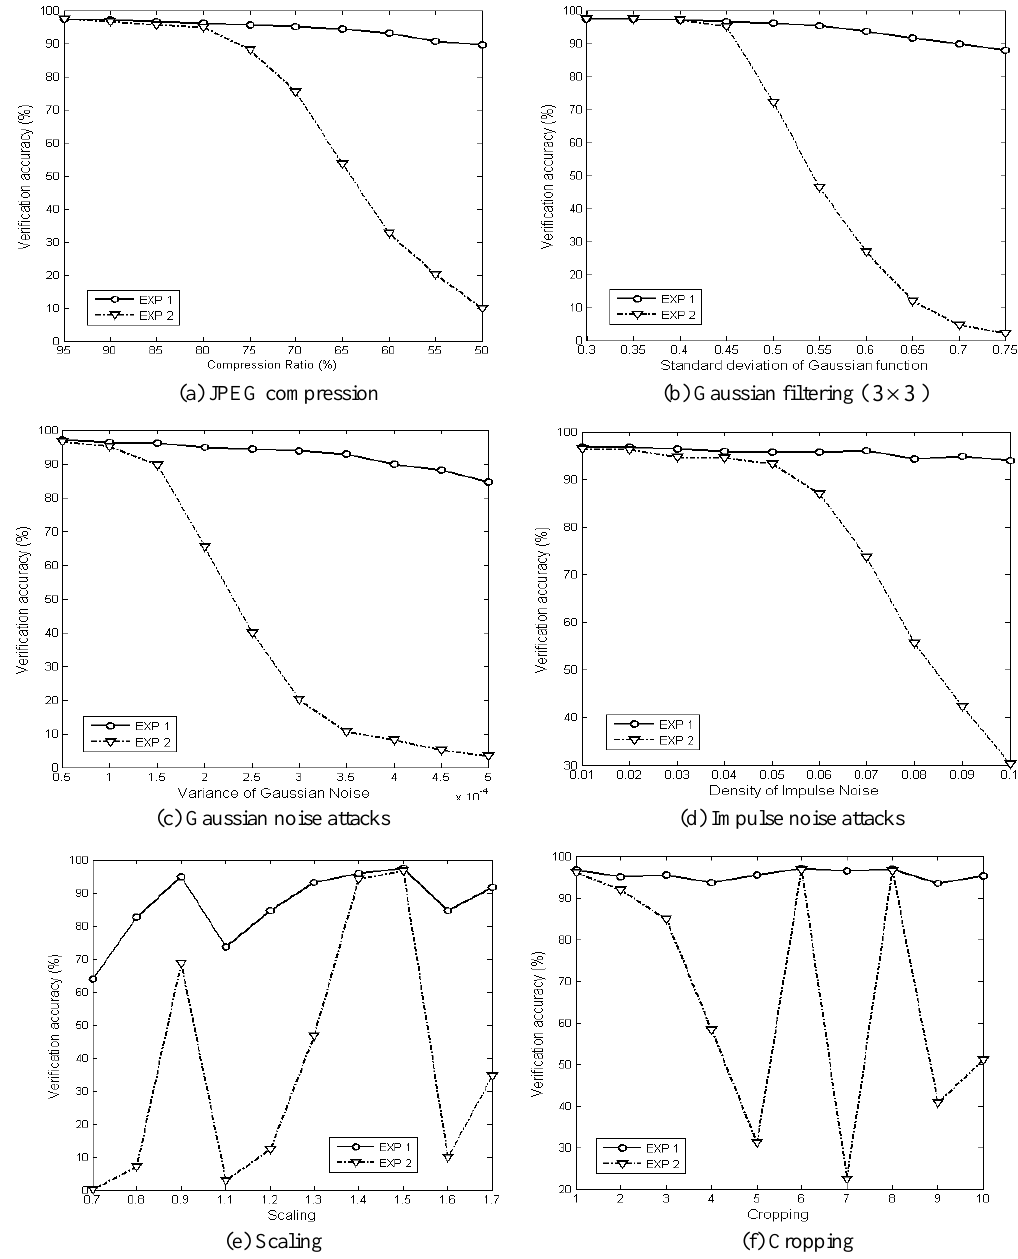
Fig. 8. Verification accuracy comparisons of various